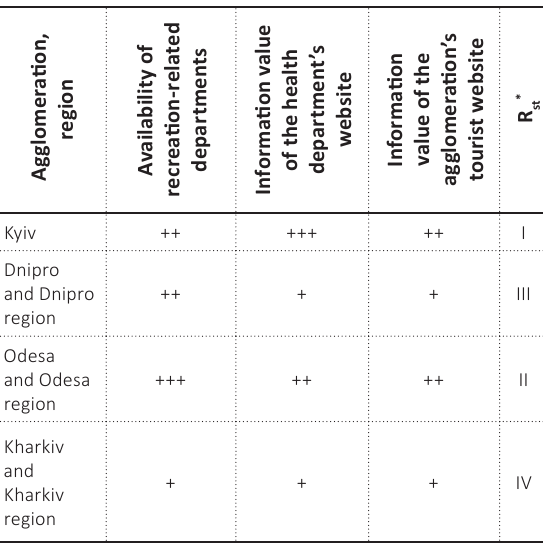
Table 2 (State Statistics Service of Ukraine,